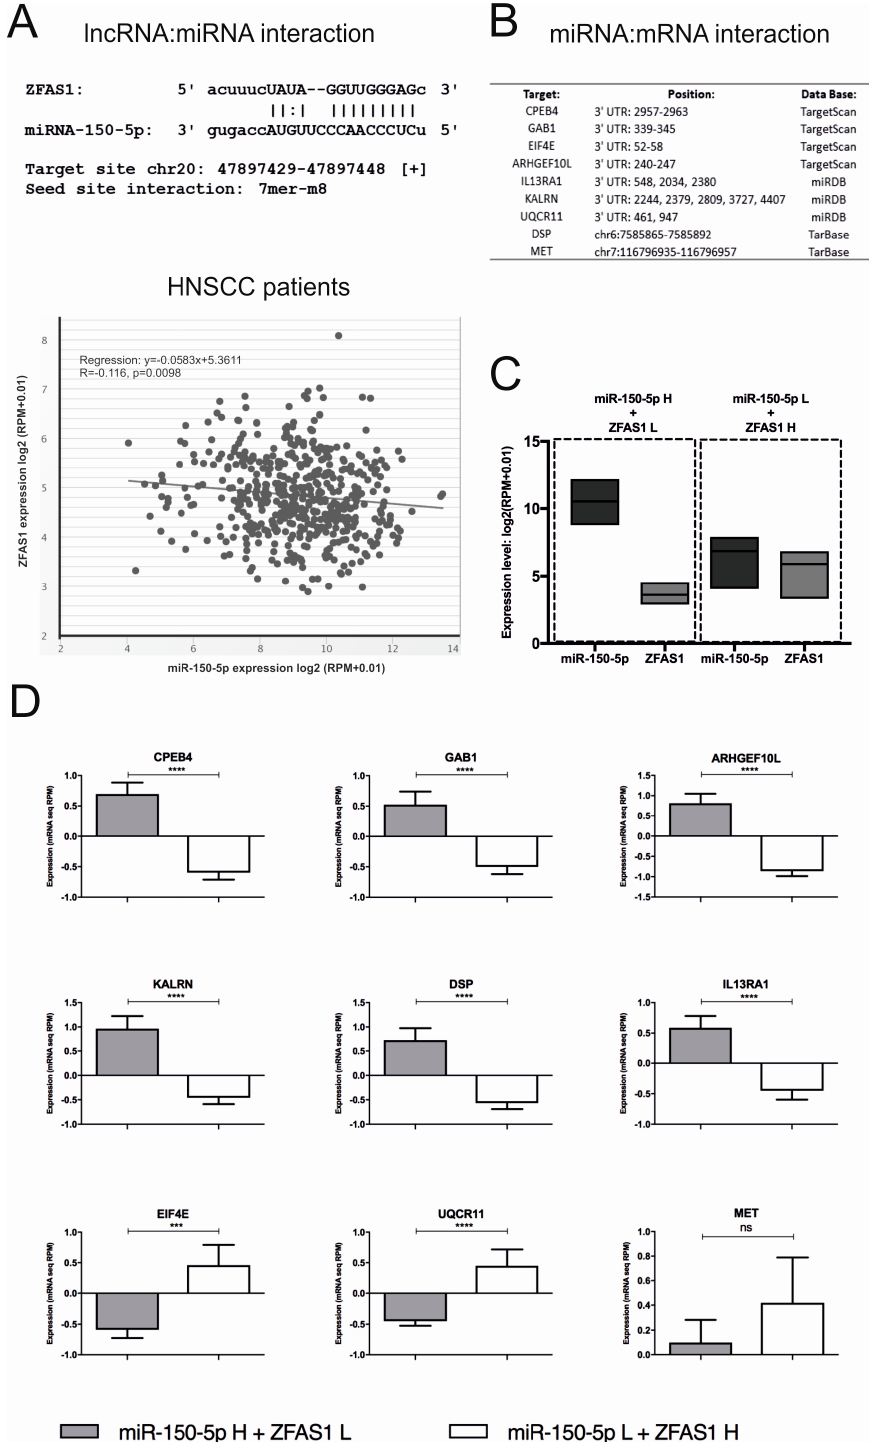
Figure 5. ZFAS1 regulation of miR-150-5p and its targets. ( A ) Possible interaction between lncRNA ZFAS1 and miR-150-5p sequences and co-expression of ZFAS1 and miR-150-5p in HNSCC patients; from StarBase v3.0 database. ( B ) Predicted miR-150-5p targets and position of regulation in their mRNA sequences. ( C ) The division to the groups of HNSCC patients: (i) with high level of miR-150-5p ( n = 30) and low ZFAS1 , and opposite (ii) with a low level of miR-150-5p and high ZFAS1 ( n = 30); from StarBase v3.0 database. ( D ) The expression level of the predicted miR-150-5p targets in groups of patients ( n = 60) with di ff erent expression levels of ZFAS1 and miR-150-5p ; expression level presented as mean with SEM; un-paired T-test; ns – no significant, *** p < 0.001, **** p <